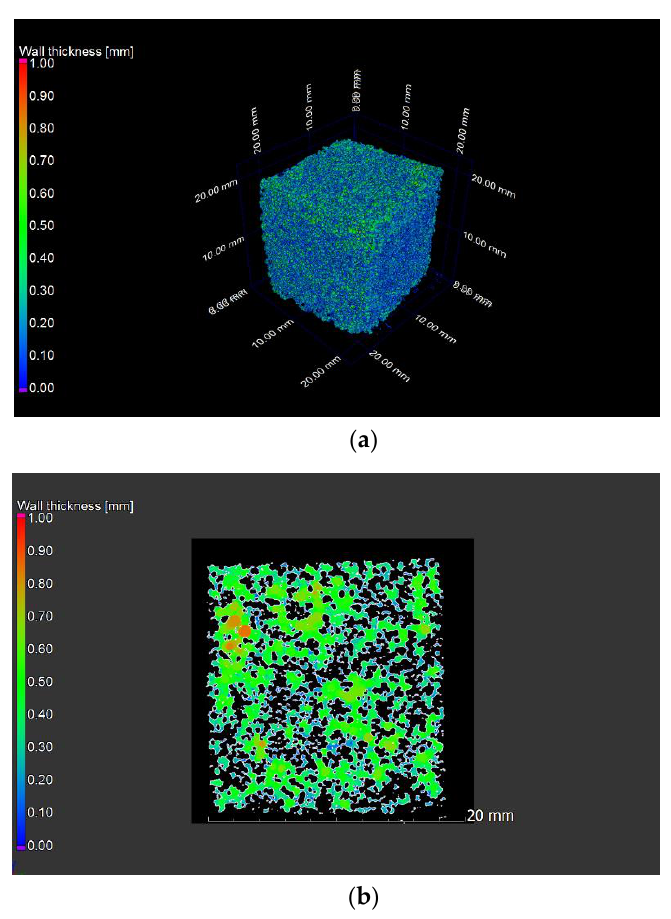
Figure 5. ( a ) Three-dimensional microstructure of typical reticulated porous diatomite-kaolin composite with a pore density of 80 PPI, prepared under optimized processing conditions, and reconstructed by µ -CT. ( b ) Representative slice taken from the corresponding µ -CT